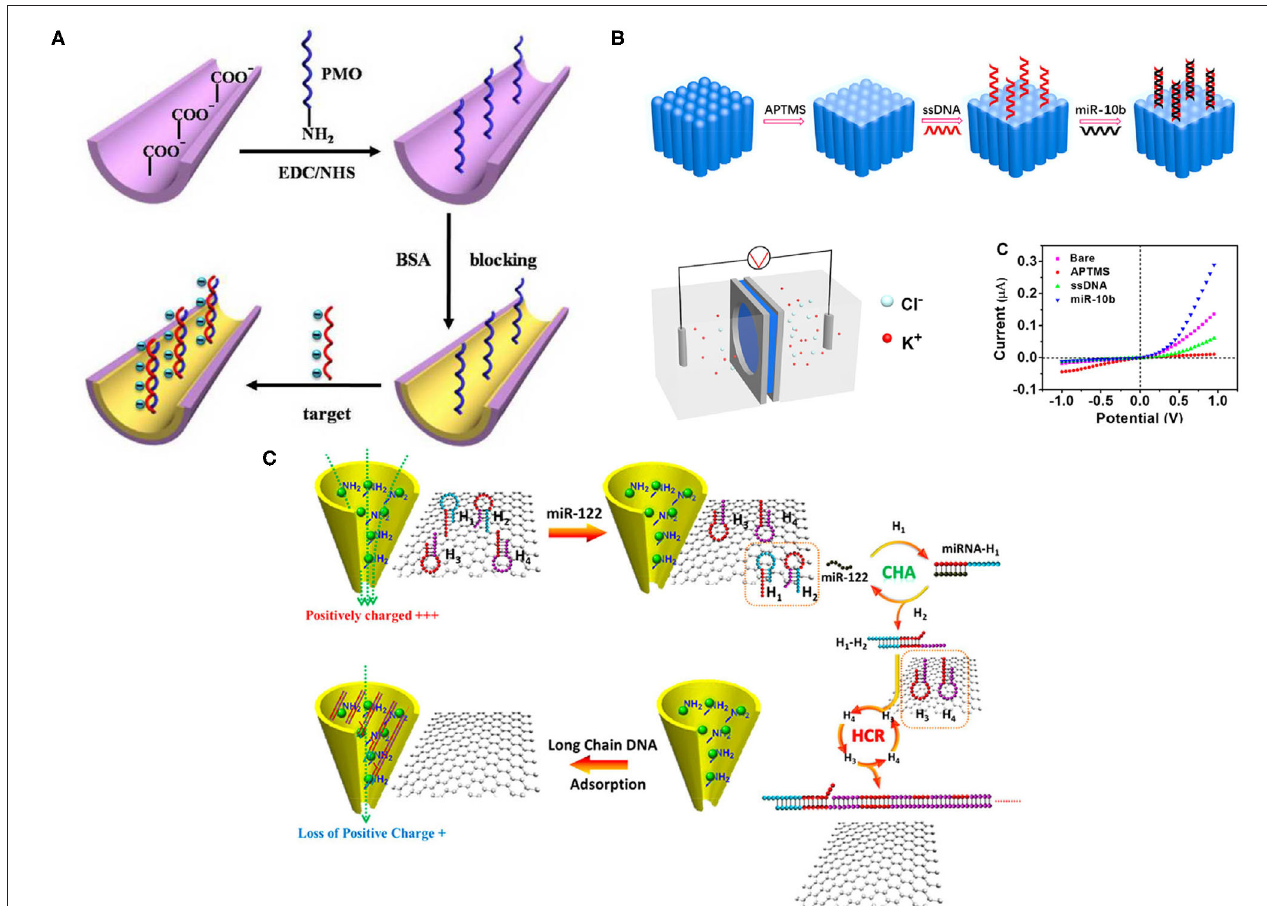
FIGURE 2 | (A) A schematic of microRNA (miRNA) detection, using Phosphorodiamidate Morpholino Oligos (PMO)-functionalized nanochannel. Nanochannels were first prepared in Poly-ethylene terephthalate (PET); amine-modified PMO groups were then added onto nanochannel after ionized carboxylic groups modification. Bovine serum albumin (BSA) also brought more negative charges and blocked the surface. Once miRNAs were hybridized with PMO, charge density changes were detected and monitored (Liao et al., 2017). (B) A schematic of miRNA detection on the nanochannel-ionchannel. When miRNA was added, a single-stranded DNA (ssDNA) probe could recognize it via hybridization. Subsequently, the homemade electrochemical cell detected the different charge densities. The miR-10b showed the dramatic current change in the system ( Zhang S. et al., 2020). (C) A schematic of miR-122 detection in the nanochannel. Positive charges of Zr 4 + -PEI-coated nanochannel were reduced after adding long-chain DNA due to its negative charge, allowing charge modification with a small number of targets. Once adding miR-122, it initiated multiple cycles of self-assembly between H1 and H2, generated H3 and H4, leading to lots of long ssDNAs, causing ion current changes on the nanochannel (Zhao et al., 2019). All copyright 2021 American Chemical